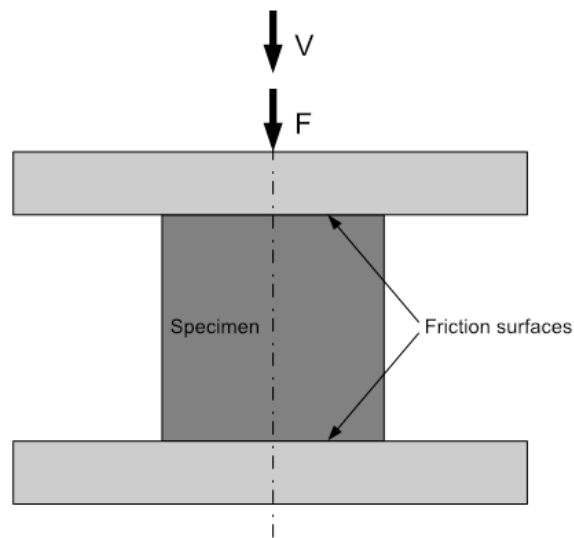
Figure 1. Schematic diagram of a generic test. Teflon (polytetrafluoroethylene PTFE) or mineral oil have been used as lubricants. Some specimens have been upset with no lubricant. Table 1 shows the used combinations of the types of lubricant and surface treatment. The table is self-explanatory. The tests have been conducted on a Sach and Kieselbach hydraulic press with a capacity of 6.3 MN at room temperature and V = 0.1